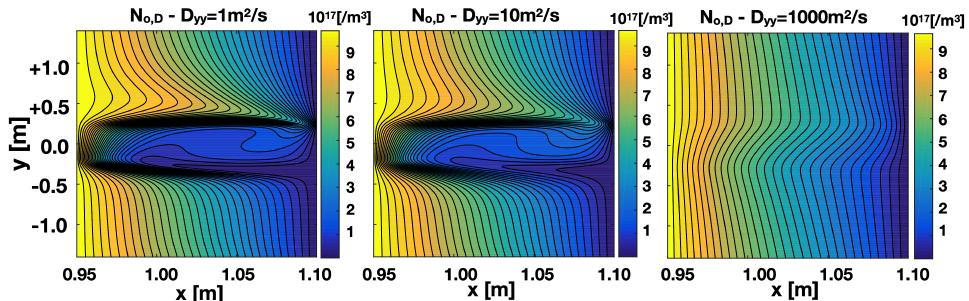
Figure 8. RF corrected zero-order density for very low (1 m 2 /s; left ), low (10 m 2 /s; middle ), and moderately high (1000 m 2 /s; right ) parallel diffusion for parameters corresponding to the electric field shown in the bottom plots of Figure 3.